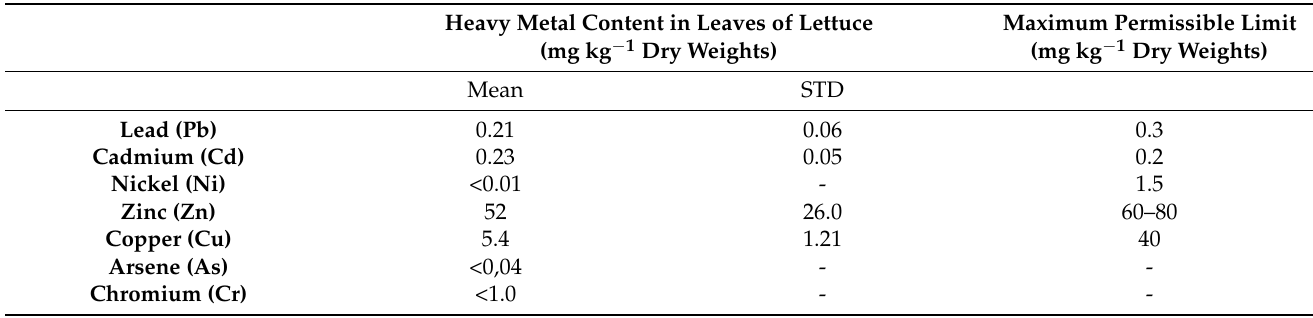
Table 5. Heavy metals content in the leaves of lettuce grown in the organic nutrient solution and maximum permissible limit in lettuce for human consumption [25]. Mean values and standard deviations (STD) are